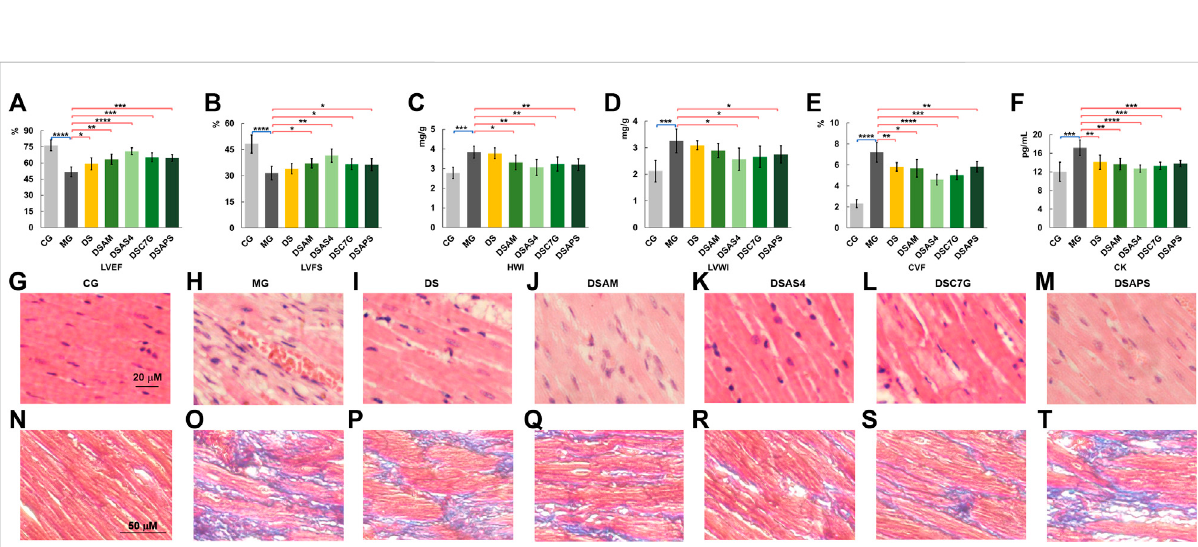
FIGURE 3 Phenotypic and pathological characterization (A – F), left ventricular ejection fraction (LVEF, (A) , left ventricular fraction shortening (LVFS, (B) , heart index (HWI, (C) , left ventricular mass index (LVWI, (D) , collagen volume fraction (CVF, (E) of myocardial cells, and plasma CK levels (F) of rats of the control (CG), model (MG), and treated groups with Descurainia sophia seed decoction alone (DS), and Descurainia sophia seeds plus Astragalus mongholicus decoction (DSAM), Descurainia sophia seeds decoction plus astragaloside IV (DSAS4), calycosin-7-glucoside (DSC7G), or Astragalus polysaccharides (DSAPS). The results of LVEF, LVFS, HWI, LVWI, CVF, and CK were measured by randomly selecting six rats (n = 6) from each group and are represented as mean ± SD. * p < 0.05 and ** p < 0.01, *** p < 0.001 and **** p < 0.0001, represent statistical signi fi cance and high signi fi cance, respectively. (G – M) H&E (400×) and (N – T) Masson ’ s (200×) trichrome staining of heart tissues of all groups. For Masson ’ s staining, collagen fi bers were stained in blue, and myocardial cell in dark